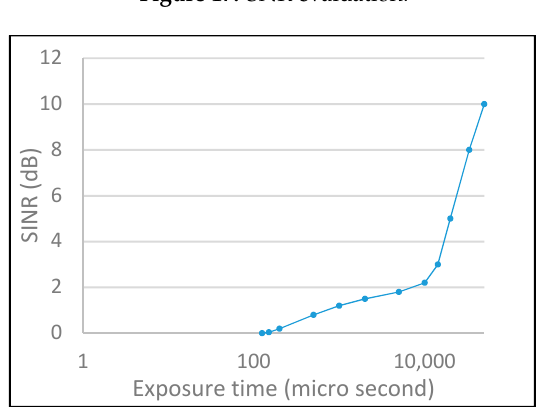
Figure 18. SINR Figure 18. SINR evaluation.